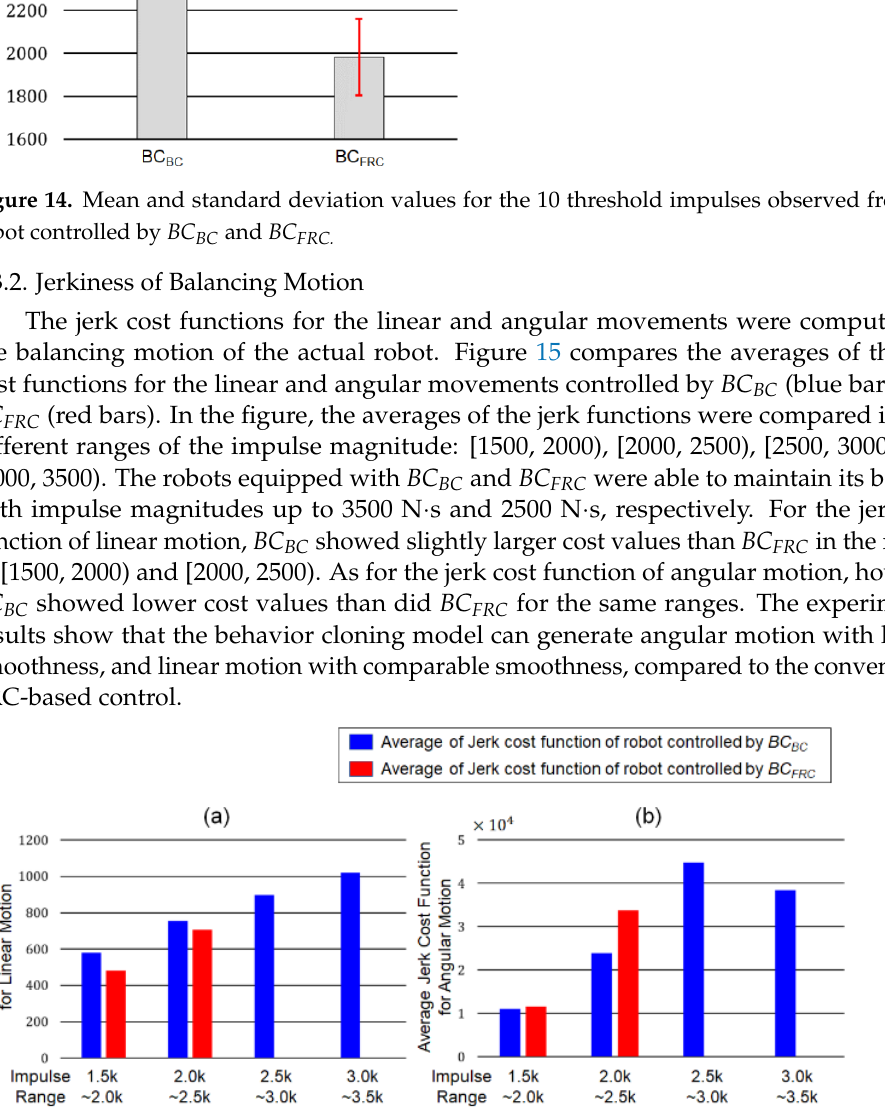
Figure 15. Averages of the jerk cost functions calculated from the balancing motion under the external force whose impulse belongs to each sub-range: [1500, 2000), [2000, 2500), [2500, 3000), and [3000, 3500). Blue and red bars representing the averages of the jerk cost functions calculated from the robots controlled by BC BC and BC FRC , respectively. ( a ) Average of the jerk cost functions for linear movement, ( b ) Average of the jerk cost functions for angular motion.